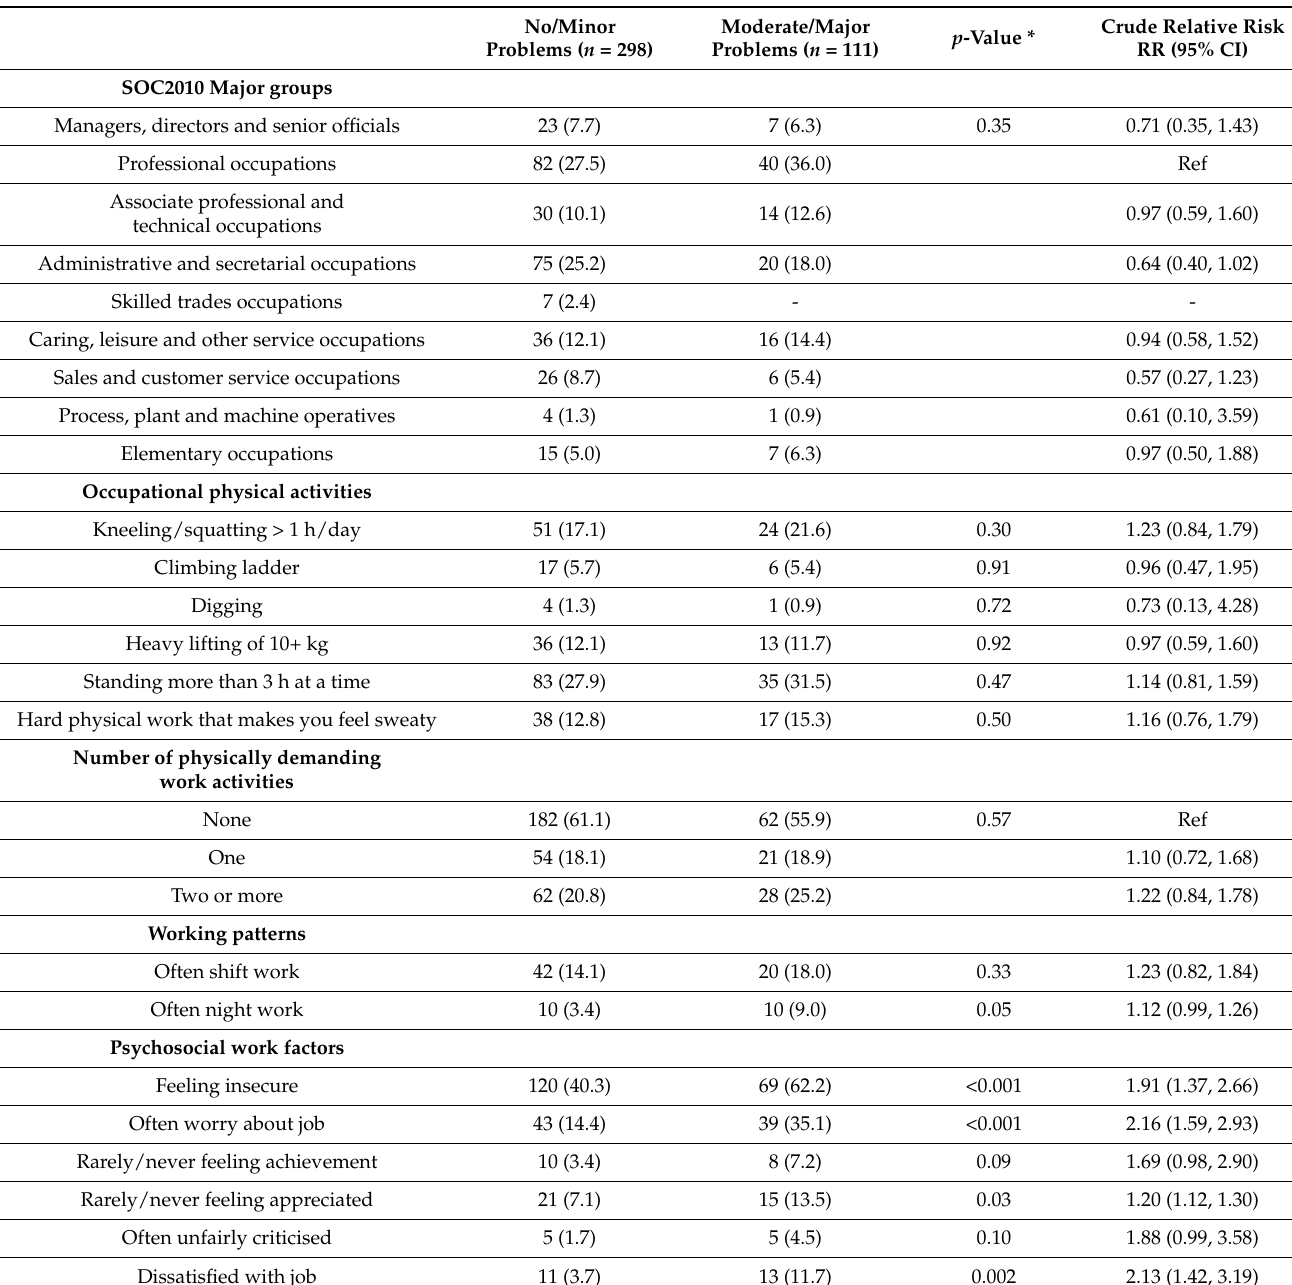
Table 2. There were no differences by type of job or physical work characteristics or night/shift work. However, women who reported that their job was insecure, that were worried about their work, felt unappreciated or were dissatisfied with their job were more likely to report at least moderate problems coping with their menopausal symptoms at work. Table 2. Relationship between occupational characteristics and reporting difficulties coping with menopausal symptoms at work amongst 409 women who were working at the time of their